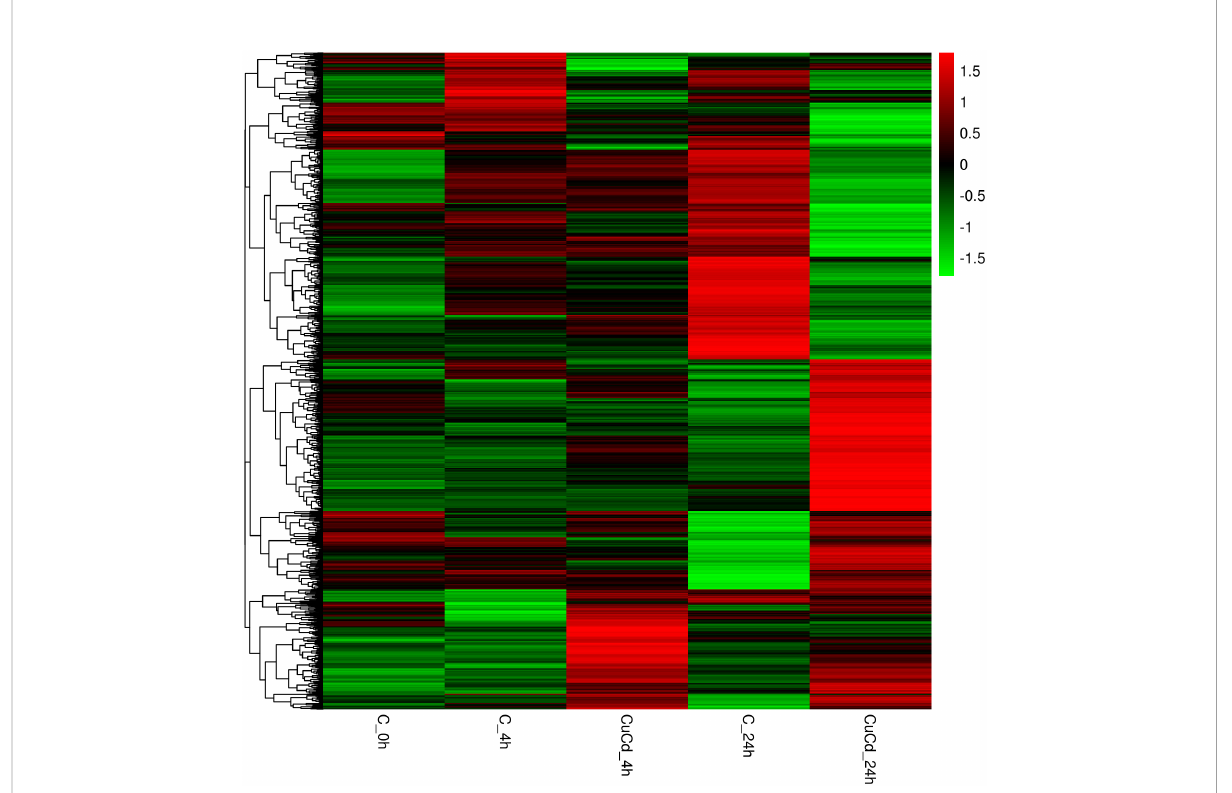
FIGURE 3 DEGs expression clustering. The gene expressions in different groups are shown in a row; the gene expressions in each group are represented in a